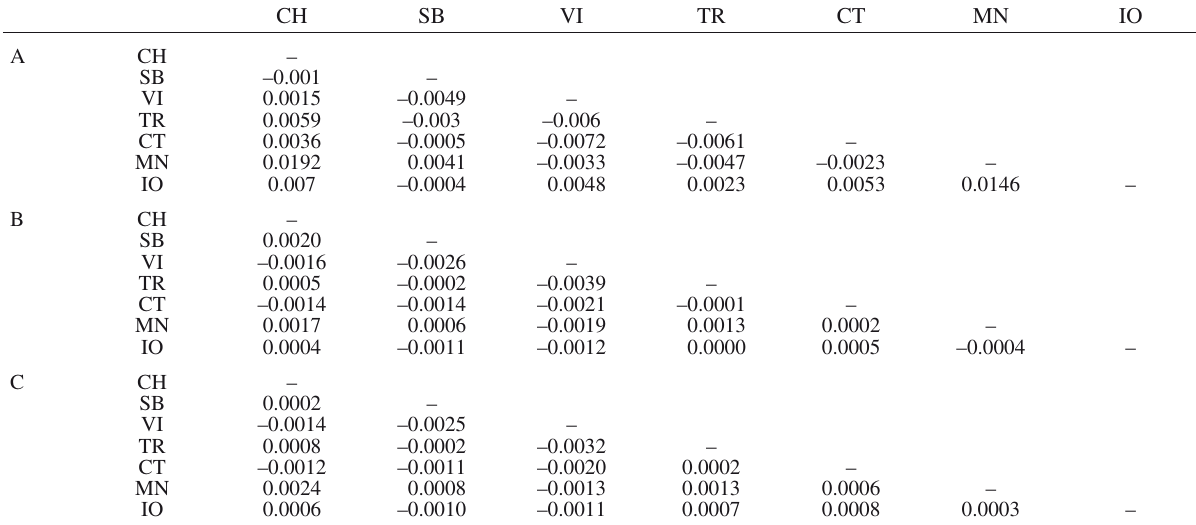
(A), r R (B) and ENA F ST ST